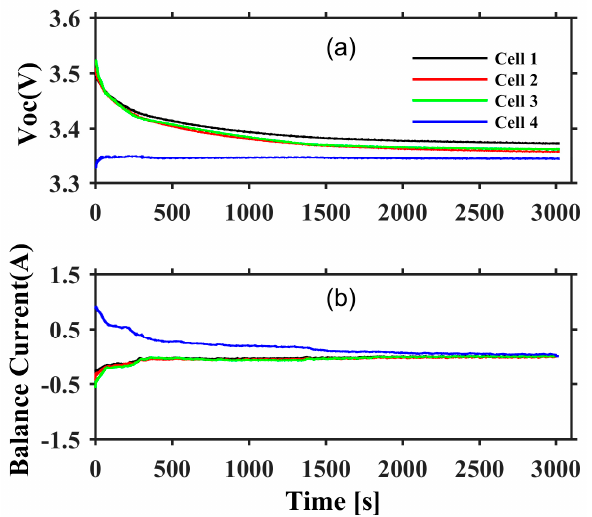
Figure 15. Experimental results for the LiFePO 4 battery pack with a proportional-integral (PI) controller. ( a ) OCV for each cell; ( b ) Average balancing current for each cell.